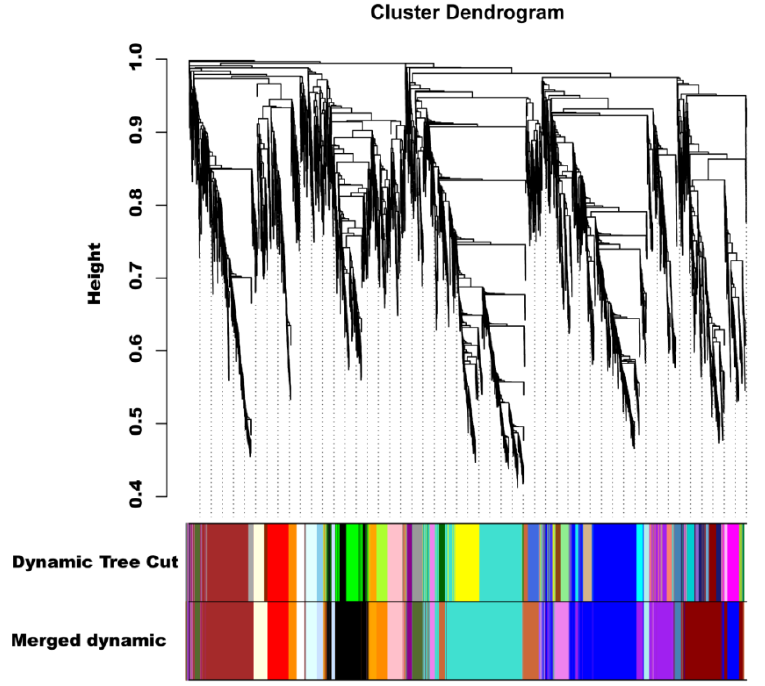
Figure 8. Hierarchical clustering presenting twenty modules with coexpressed genes.